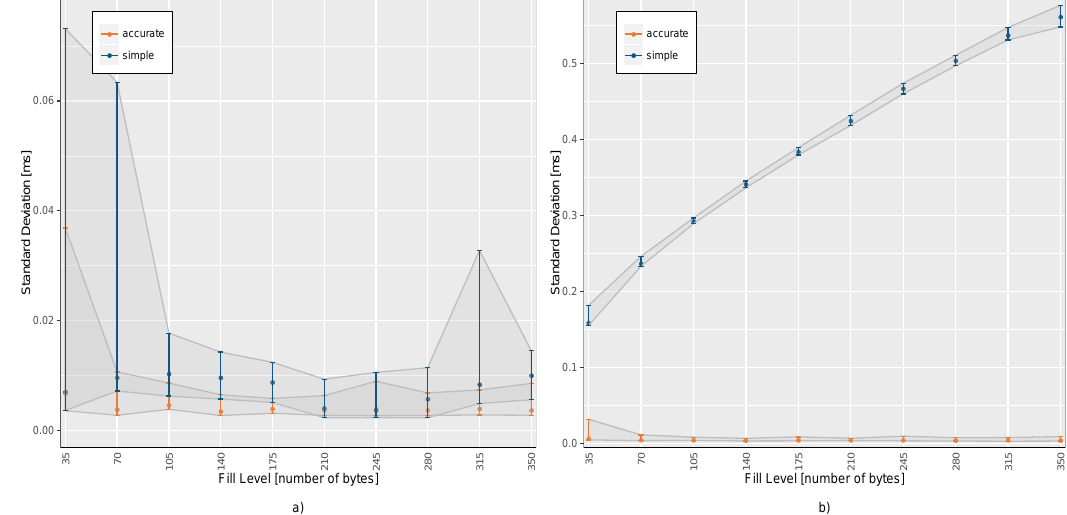
Figure 7. Comparison of resulting sample-to-sample distances for ( a ) sensor 1 with no measurable relative drift ( D = 0.0%) and ( b ) sensor 2 with a mean relative drift D = 1.6% using simple and accurate time stamp reconstruction